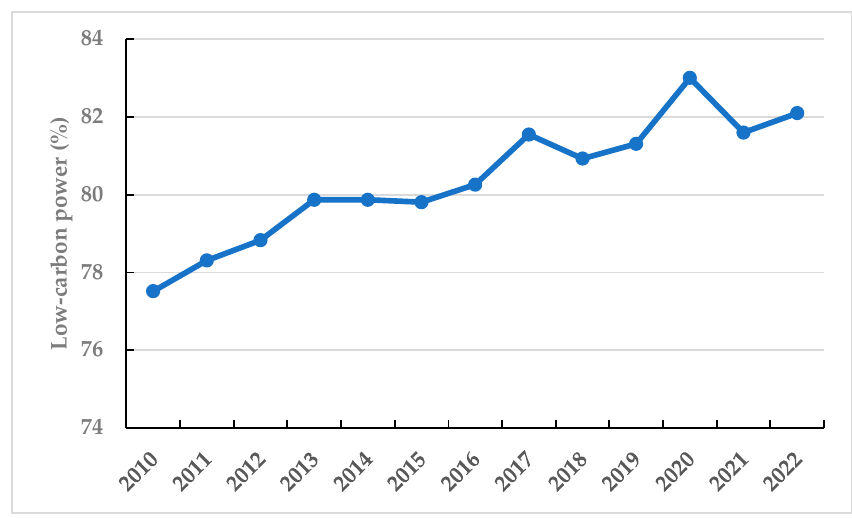
Figure 7. Low-carbon energy from renewable energy resources in operation in Canada between 2010 and 2022 [18,109,112].